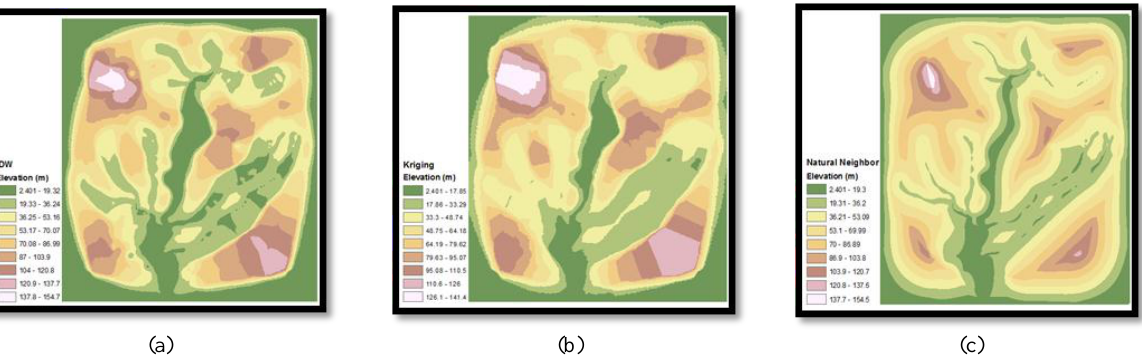
Figure 4. The results of interpolation using: (a) IDW, (b) OK, and (c) NN